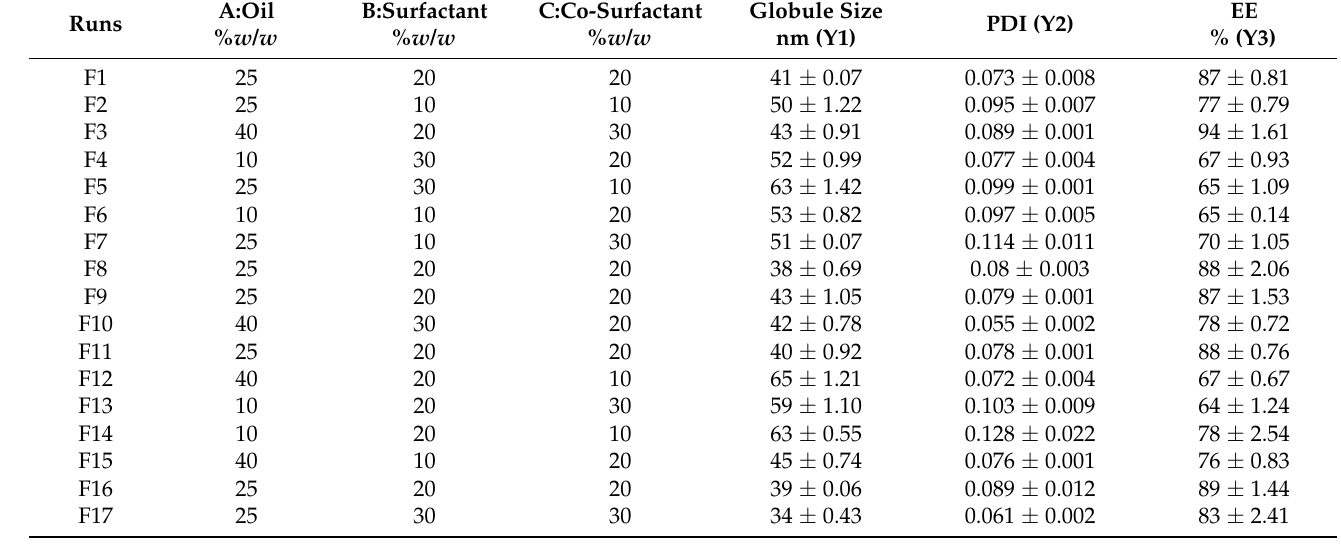
Table 1. Observed responses of different NEs formulae based on independent variables.